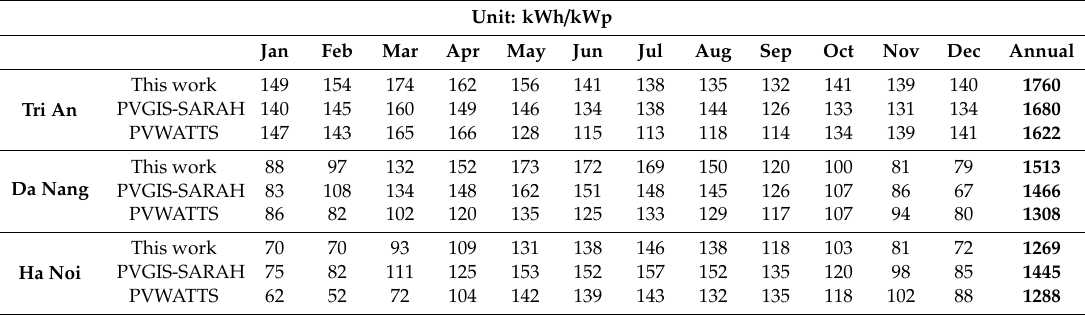
Table 4. Electricity energy yield of 1 kWp horizontal Si-based commercial PV installation for di ff erent regions in Vietnam.